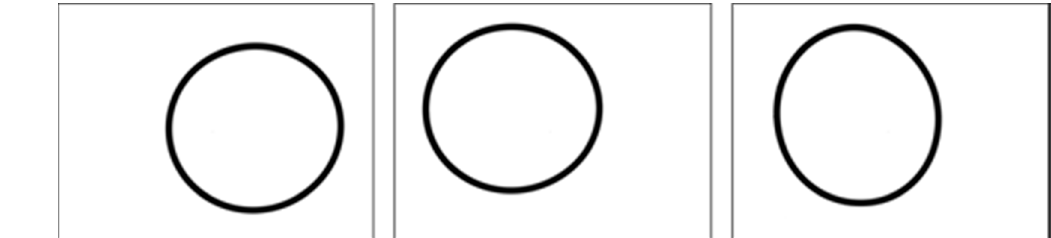
Figure 22. Schematic diagram of the O-ring repeatedly on the object plane.